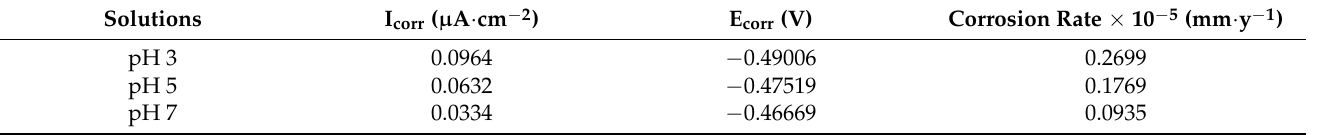
Figure 2. Potentiodynamic polarization curves of LPBFed Ti–6Al–4V in Hank’s solution with different pH values, at 37 °C. Table 1. Fitting results and calculated corrosion rate of potentiodynamic polarization curves of LPBFed Ti–6Al–4V in Hank’s solution with different pH values, at 37 °C. I corr is the corrosion current density; E corr is the corrosion potential.